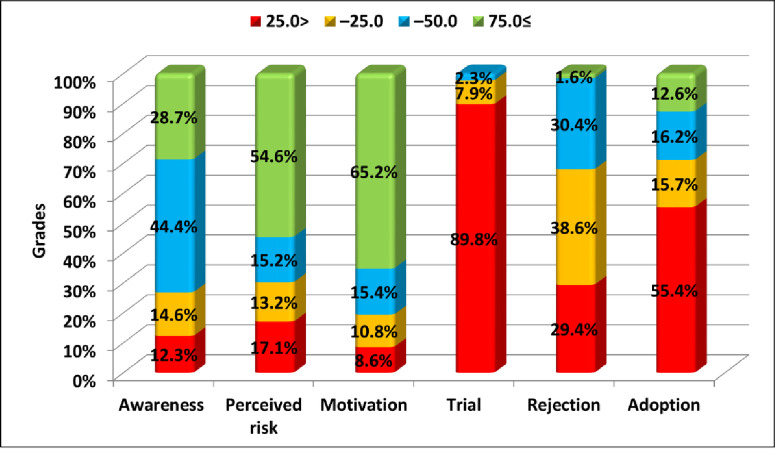
Grading scores per level of behavior development.